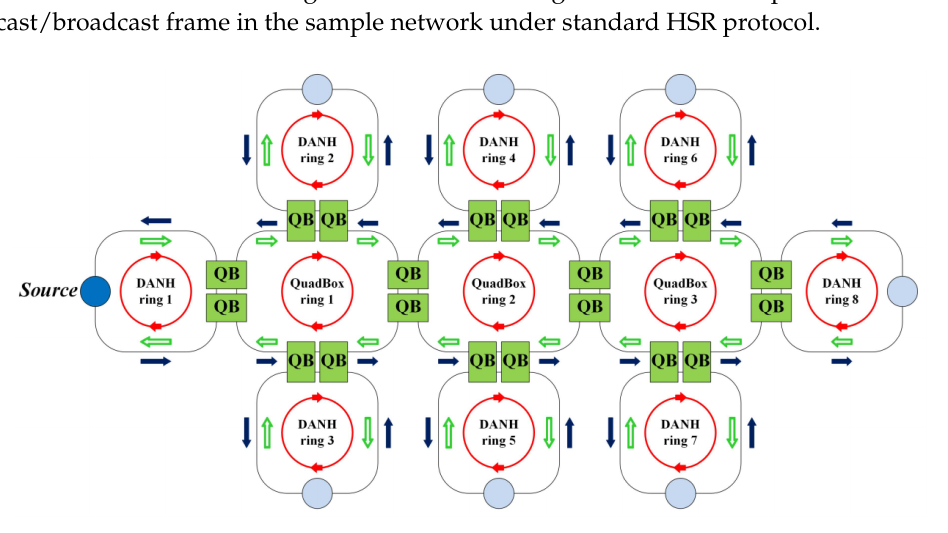
Figure 20. Network multicast/broadcast traffic under standard HSR